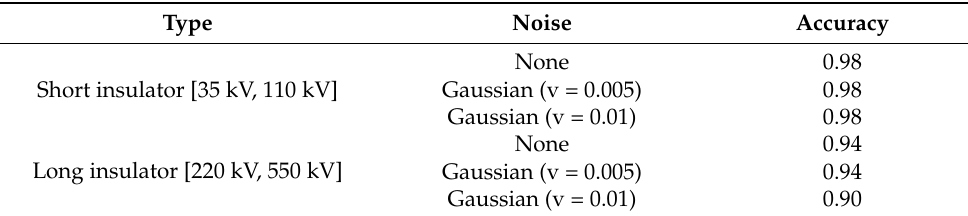
Table 4. Comparison with other target detection